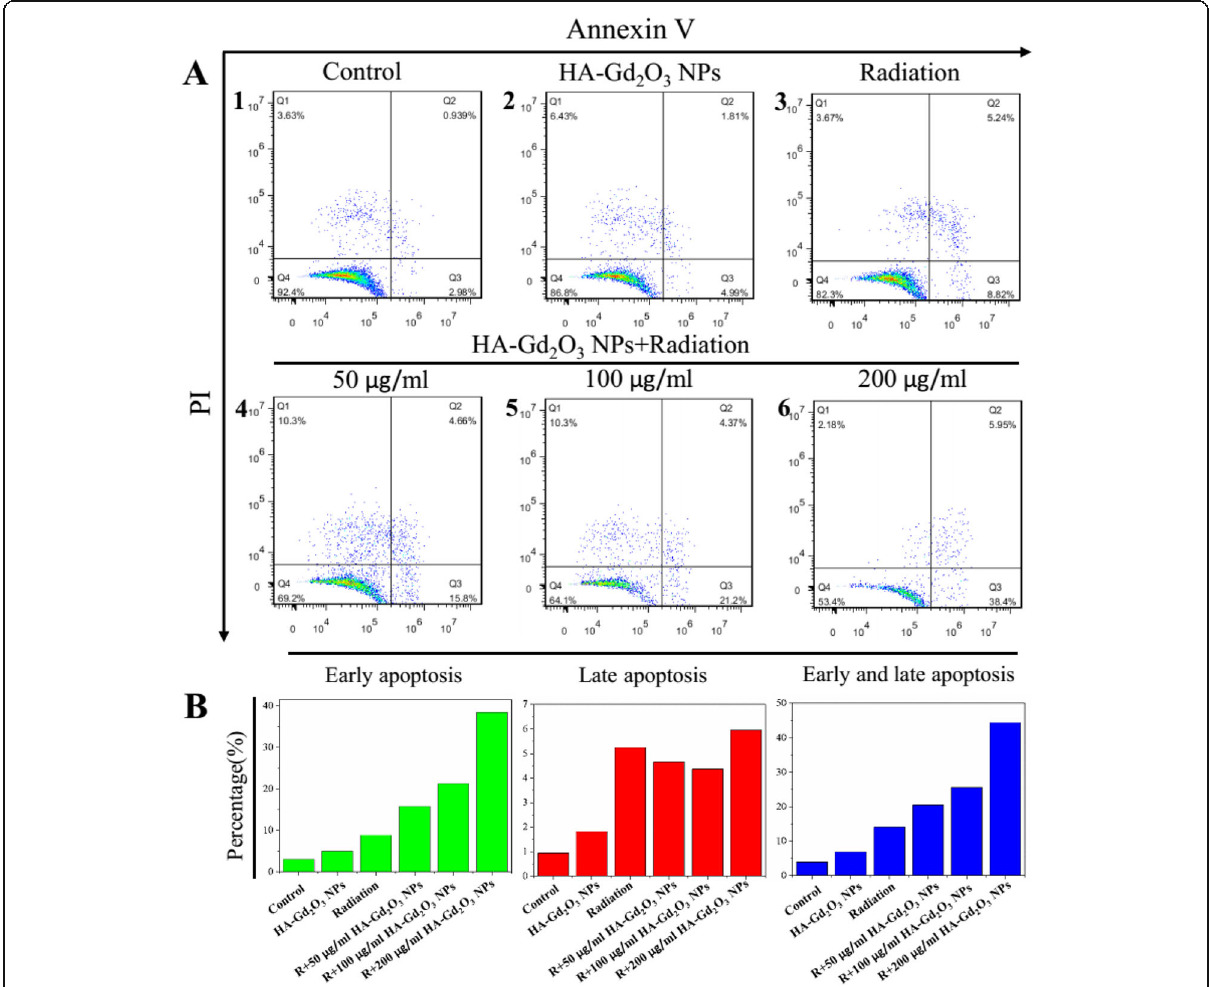
Fig. 8 The apoptosis analyses of HA-Gd 2 O 3 NPs. a The apoptosis levels of HepG-2 cells at 24 h after treatment of X-ray radiation. b The corresponding quantitative